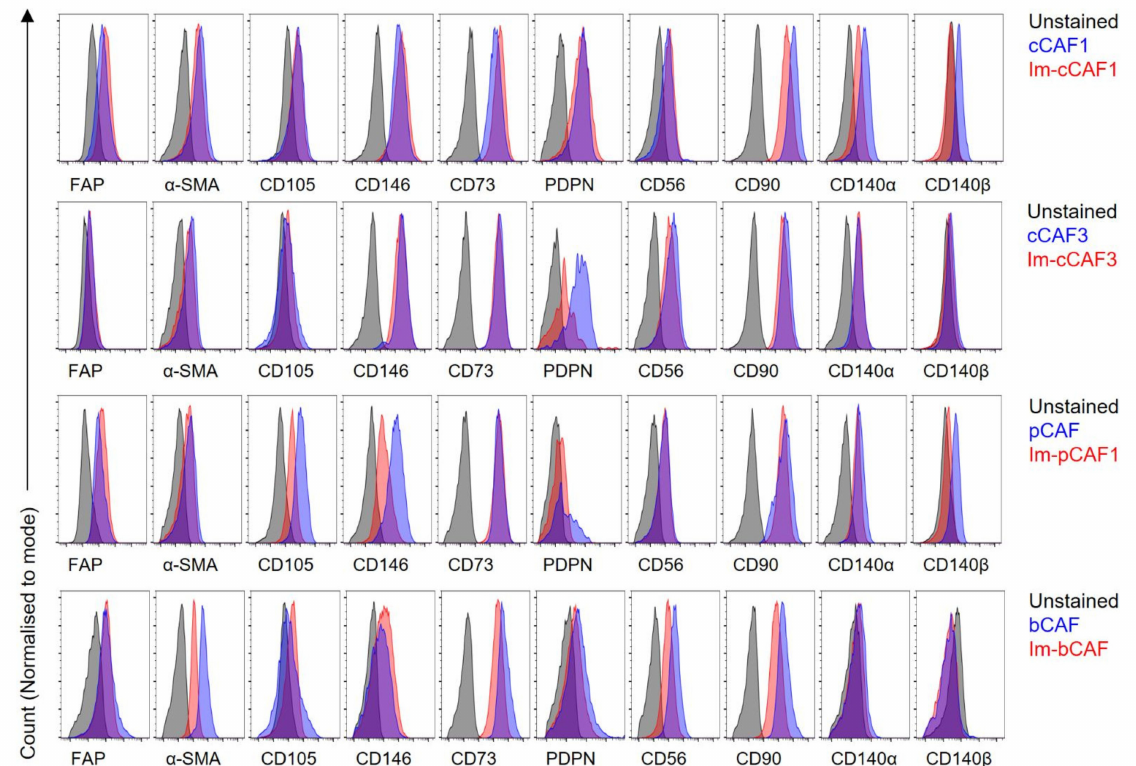
Figure 2. Phenotype of immortalized CAFs. Primary CAFs at passage 3 and immortalized (Im-)CAFs at passage 4–5 were phenotyped for a range of characteristic CAF markers. Histograms shown are gated on non-debris, viable cells, and mCherry+ for Im-cCAF1, Im-cCAF3, and Im-pCAF, or GFP+ for Im-bCAF, with no fluorescent selection for primary cells. Data represent 2–3 independent